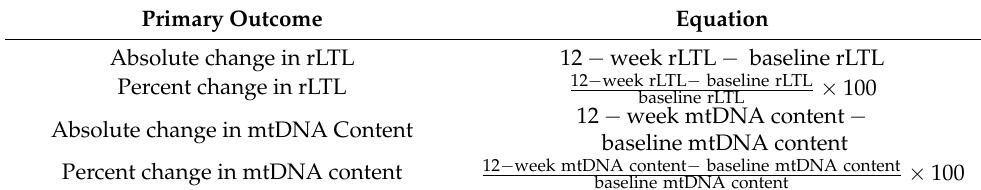
Table A1. Primary outcome equations 1